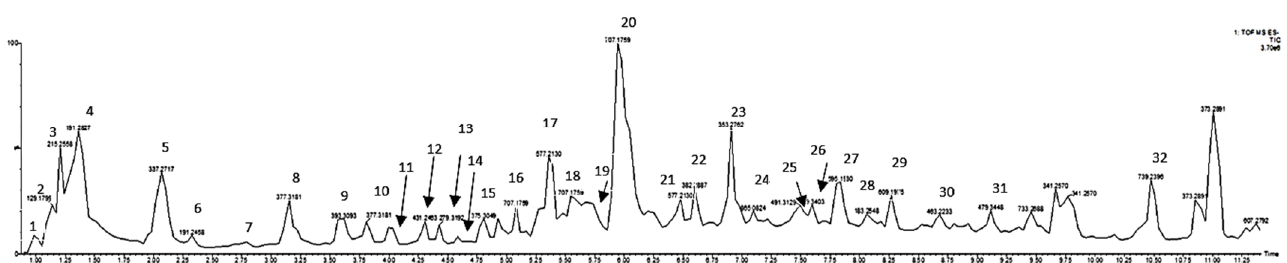
Figure 2. Representative UPLC–MS chromatogram of VO fruit. It complements Table 3.